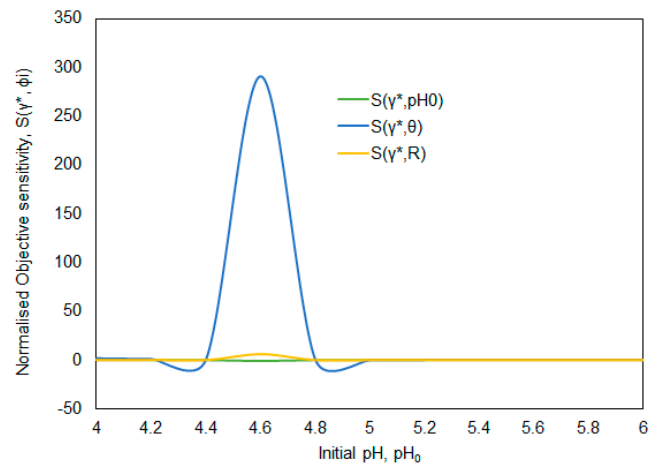
Figure 5. Normalized objective sensitivities S( γ *, ϕ i) as a function of initial pH (pH 0 ) of the system.